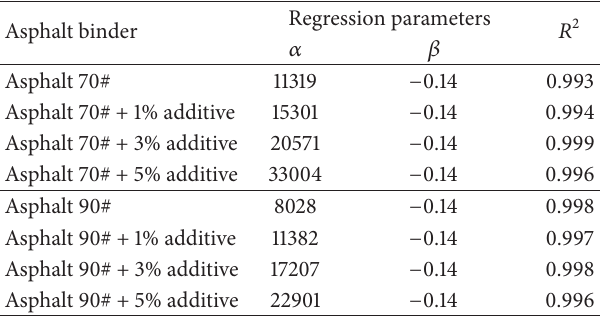
Table 2: 𝛼 and 𝛽 of asphalt with different dosage of